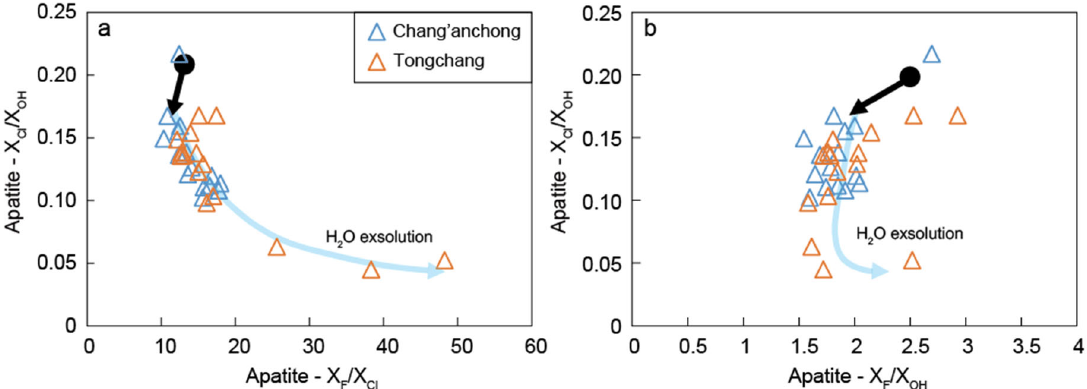
Figure 10. Volatile compositions of apatites from Tongchang and Chang’anchong quartz syenite porphyries. ( a ) Apatite volatile compositions in X Cl /X OH vs. X F /X Cl and ( b ) X Cl /X OH vs. X F /X OH . Apatite crystalliza- tion begins at the black point and continues to 22% crystallization under H 2 O-undersaturated condition according to the black arrow (initial H 2 O content is 3.5%; D c/m F ≈ 1.3 and D c/m Cl ≈ 1). Then, apatite compositional evolution continues in the blue arrow to 70% crystallization under H 2 O-saturated